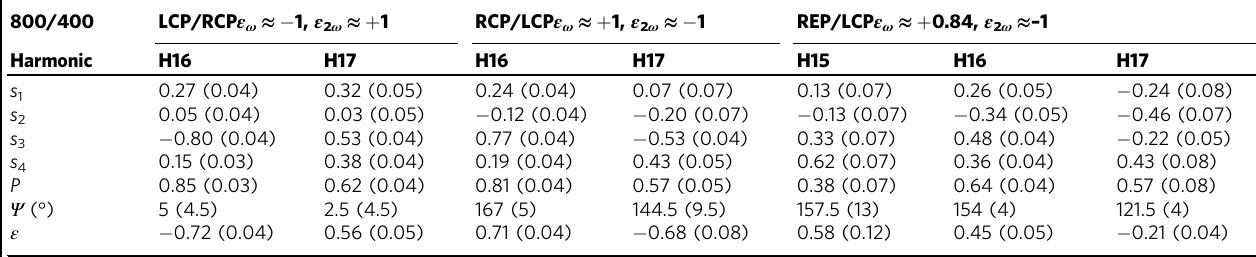
Table 1 Complete experimental characterization of the harmonic polarization state